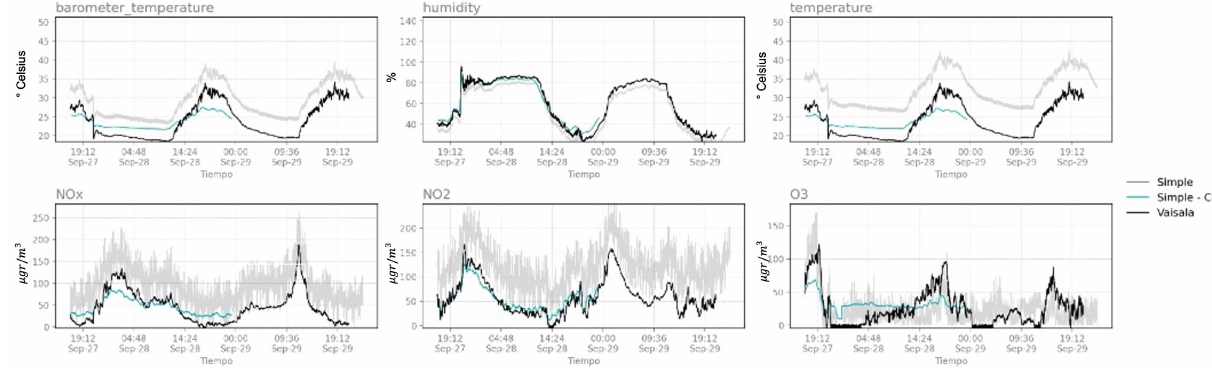
Figure 11. Qualitative comparison of the device with the Vaisala AQT400 ®calibrated